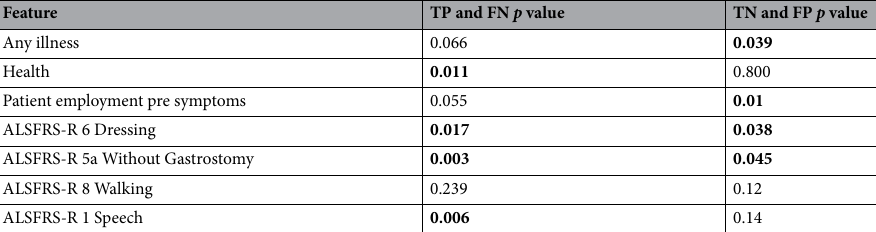
Table 6. Chi-squared test results for comparisons between TP (True Positives or Correct 1) and FN (False Negatives or Incorrect 0), as well as TN (True Negatives or Correct 0) and FP (False Positives or Incorrect 0) of categorical and ordinal features in the proposed CDSS model. In the table we present the p value of the comparison of their distributions. The values in bold show statistically significant differences between the two groups, while for the rest we could not reject the null